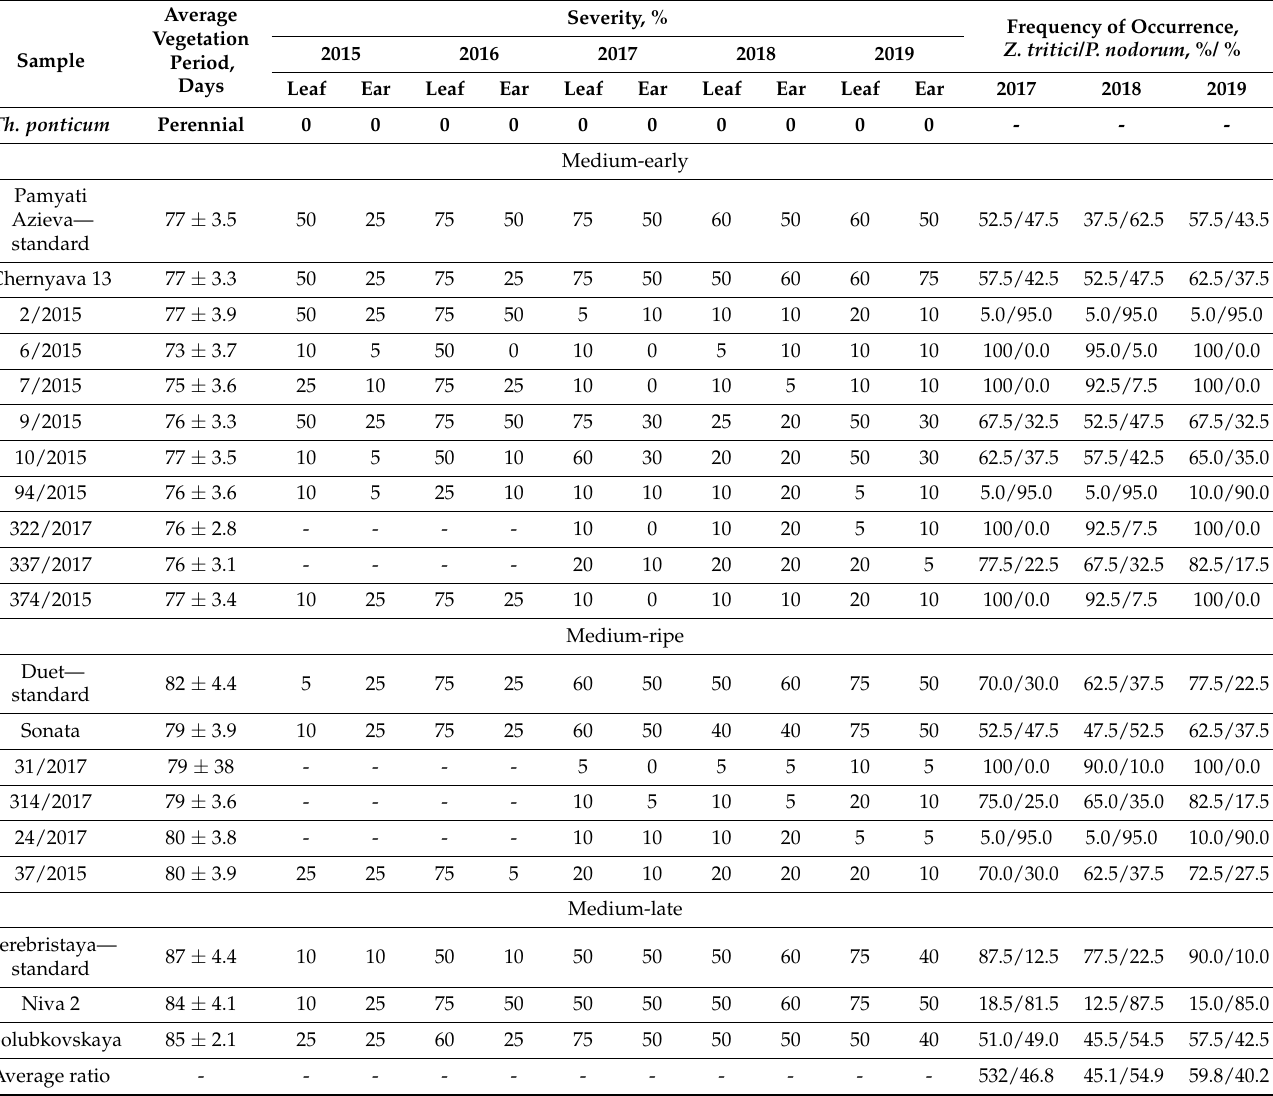
Table 2. Results of assessment of Septoria blotch severity on Thinopyrum ponticum , cultivars of spring common wheat and introgressive lines, and the frequency of occurrence of Z. tritici and P. nodorum (field conditions, natural infection background, Omsk, Russia, 2017–2019).